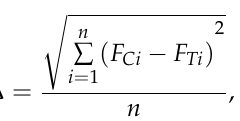
Formula (6) is introduced to get the error ( ∆ ) between calculation and test results.